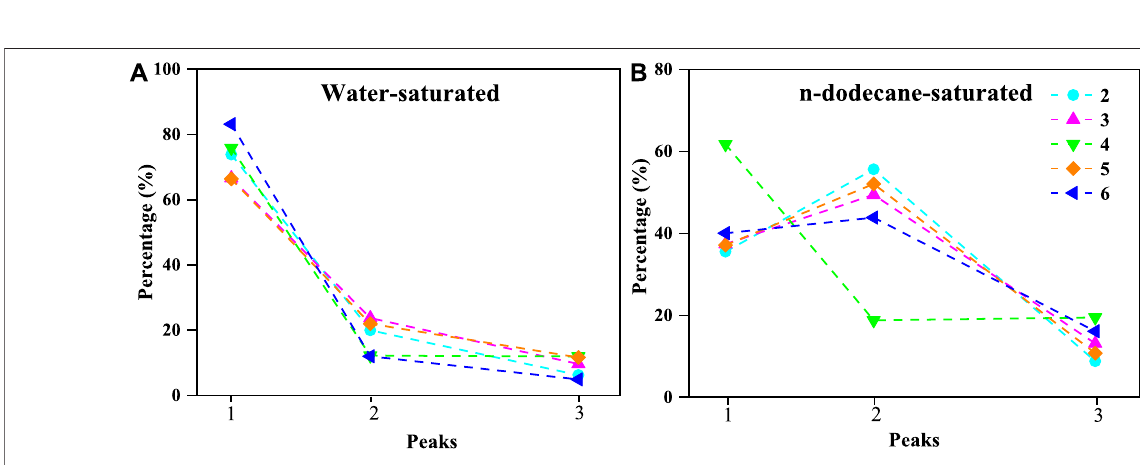
Frontiers in Earth Science |